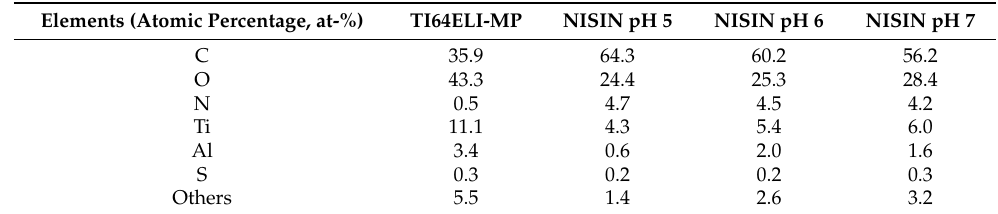
Table 1. XPS quantitative analysis of the bare MP sample and surfaces functionalized with processes at different pH values. Error for all the values is indicated at 0.1 at-%. Elements (Atomic Percentage, at-%)